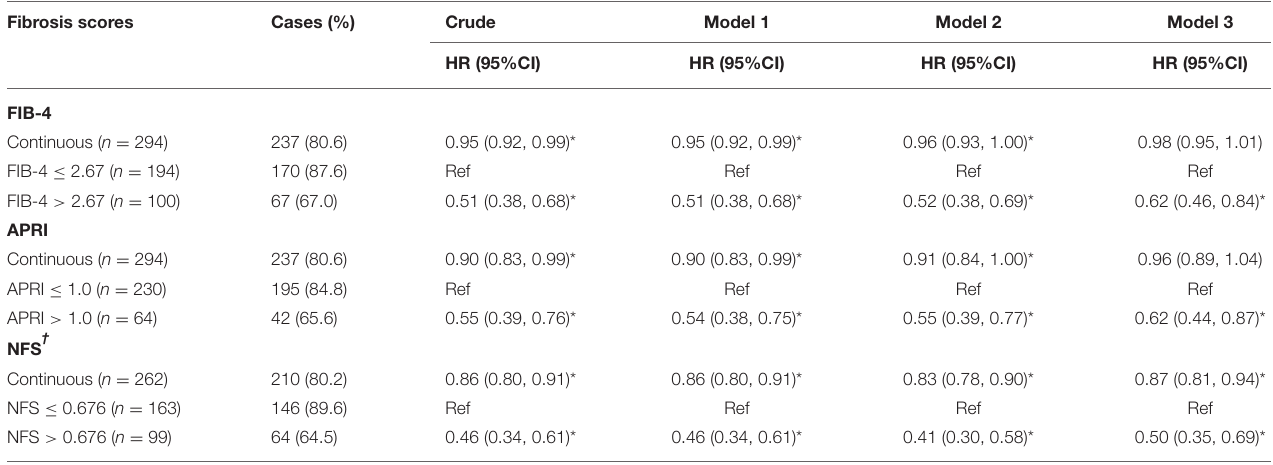
TABLE 2 | The association between Fibrosis scores and 28-days hospital discharge in patients with COVID-19. Fibrosis